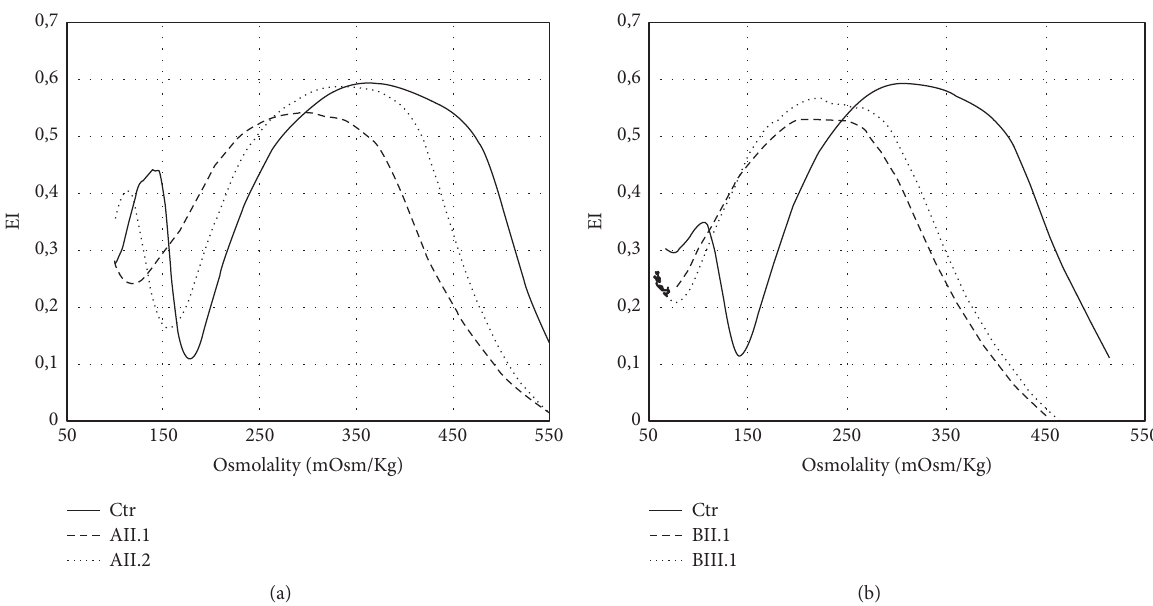
Figure 3: Results of LoRRca Osmoscan analysis in the affected patients compared to a normal control performed by Laser-Assisted Optical Rotation Cell Analyzer (LoRRca MaxSis, Mechatronics, Hoorn, The Netherlands). The osmotic gradient curves reflect RBC deformability